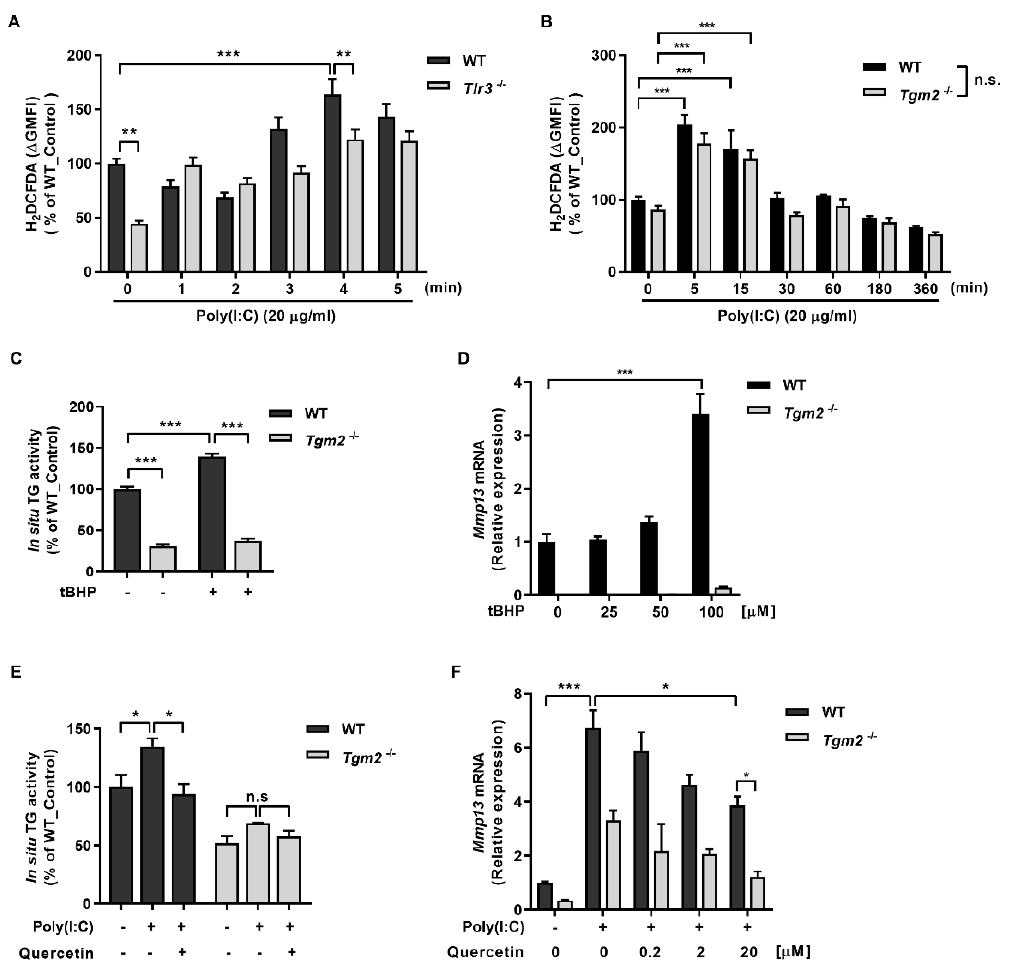
Figure 4. Poly(I:C) binding to TLR3 generates ROS that activates TG2. ( A , B ) Wild-type and Tlr3 − / − ( A ) or Tgm2 − / − ( B ) MDFs were treated with 20 µg/mL of poly(I:C) and harvested at indicated time. Levels of ROS in the cells were quantitatively measured by flow cytometry using DCFDA. ( C , D ) Wild-type and Tgm2 − / − MDFs were treated with 100 µM ( C ) or various dose ( D ) of tert-butyl hy- droperoxide (tBHP) for 12 h. The levels of intracellular TG activity ( C , n = 3) and Mmp13 mRNA (( D ), n = 3) were evaluated by BP incorporation assay and by qRT-PCR, respectively. ( E , F ) Wild- type and Tgm2 − / − MDFs were treated with 20 µg/mL of poly(I:C) for 12 h. Effect of co-treatment with